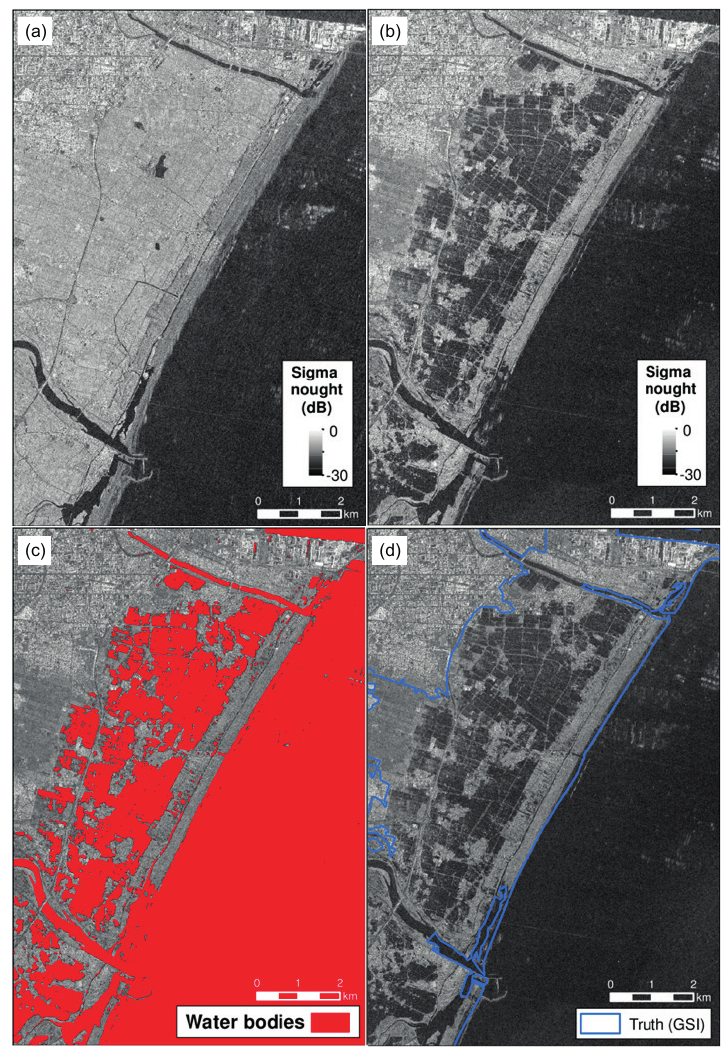
Figure 5. Tsunami Inundation Area extraction from SAR images. Case of the 2011 Tohoku tsunami [64]. ( a ) Pre-event TerraSAR-X image (20 October 2010). ( b ) Post-event TerraSAR-X image (12 March 2011). ( c ) Water bodies detected by applying threshold values. ( d ) The actual inundation line published by the Geospatial Information Authority of